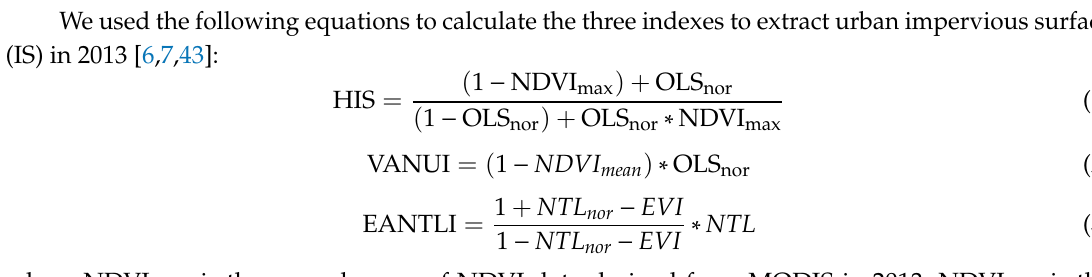
Table 1. Google Earth images were selected from the soft Google map. Some data for Beijing, Shanghai, Guangzhou, Nanjing, Wuhan, Xi’an, Urumqi, and Lanzhou originated from Google